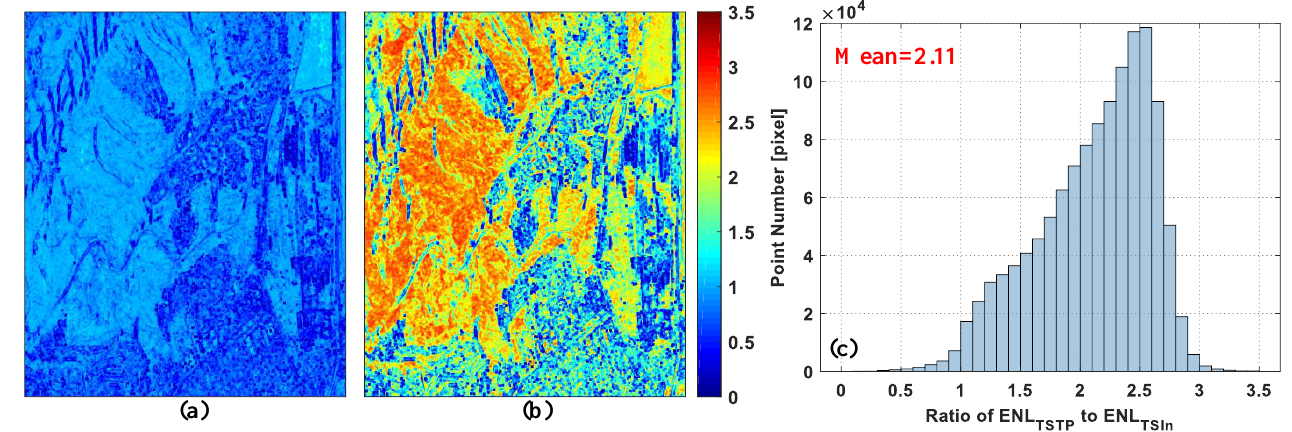
Figure 8. Estimated ENL images of full scene based on ( a ) the original TSIn coherency matrices in the HH polarization and ( b ) the original TSTP coherency matrices, and the corresponding ratio histogram ( c ) of ENL TSTP to ENL TSIn .